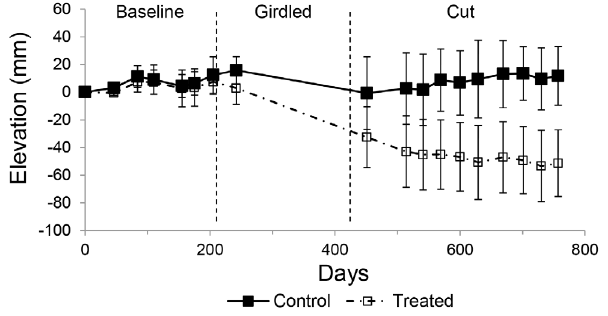
Figure 1. Trends in surface elevation change in control and treated sites in R.mucronata forest at Gazi bay, Kenya. Error bars are 95% CI. Vertical broken lines indicate periods when trees were girdled and cut in the treatment plots. Baseline, girdled and cut periods respectively. The controls and the treatment consisted of five replicates